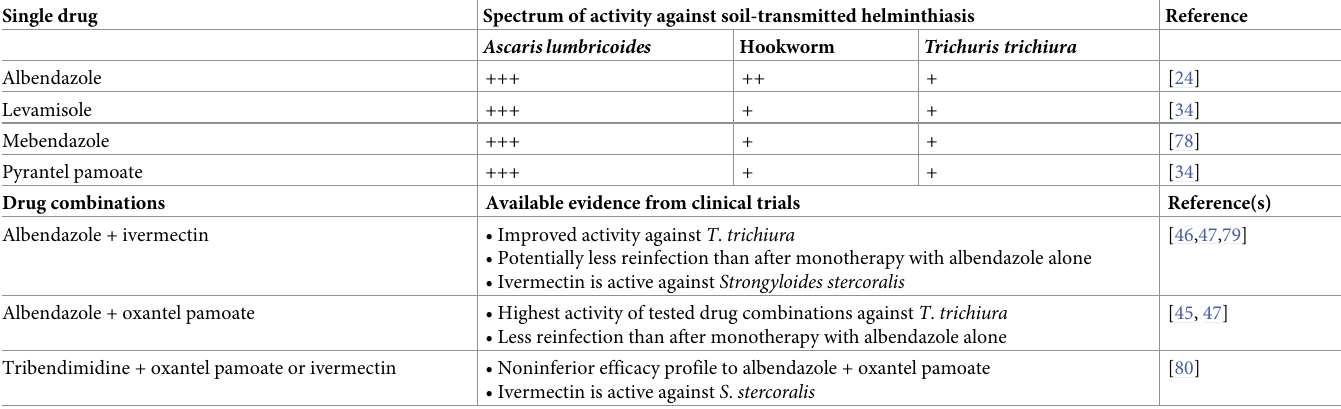
Table 2. Efficacy of anthelmintic drugs used for the treatment of soil-transmitted helminthiasis and recent evidence from clinical trials pertaining to 3 drug combinations. Single drug Spectrum of activity against soil-transmitted helminthiasis